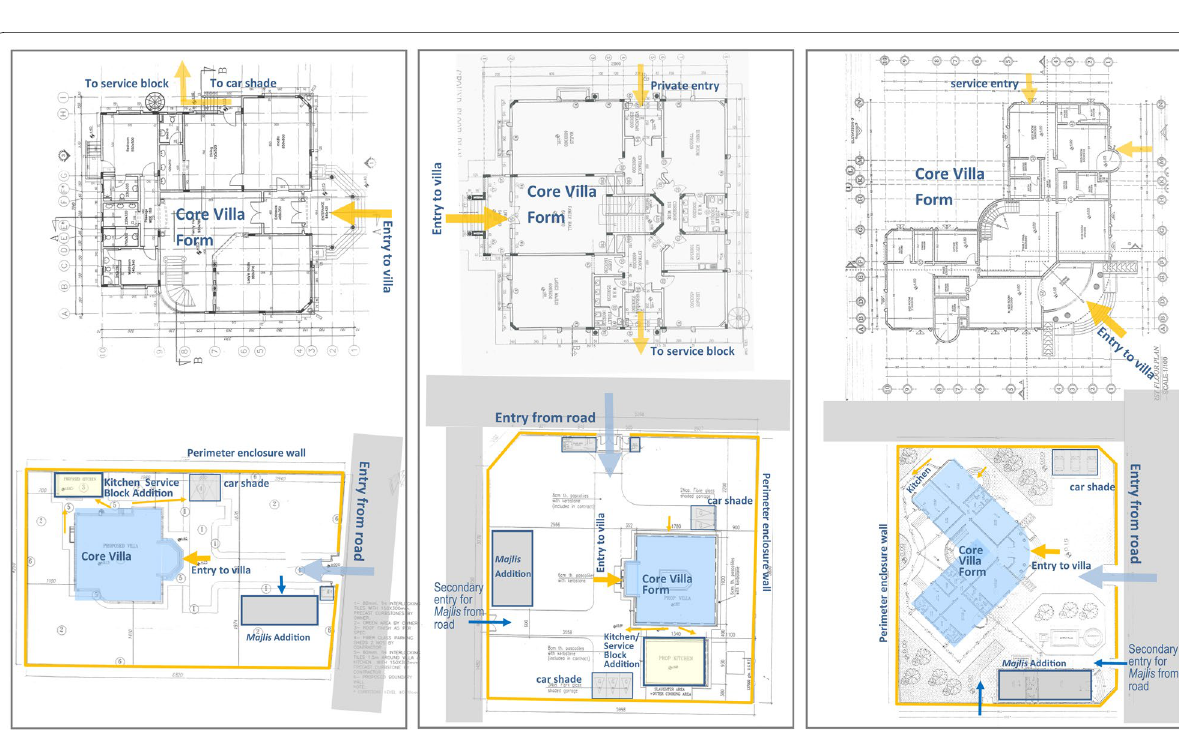
Fig. 9 Three examples of Emirati villa. Core house and initial spatial accretions planned in design stage within perimeter enclosed villa, in site plan and villa plan. Source: Authors collection